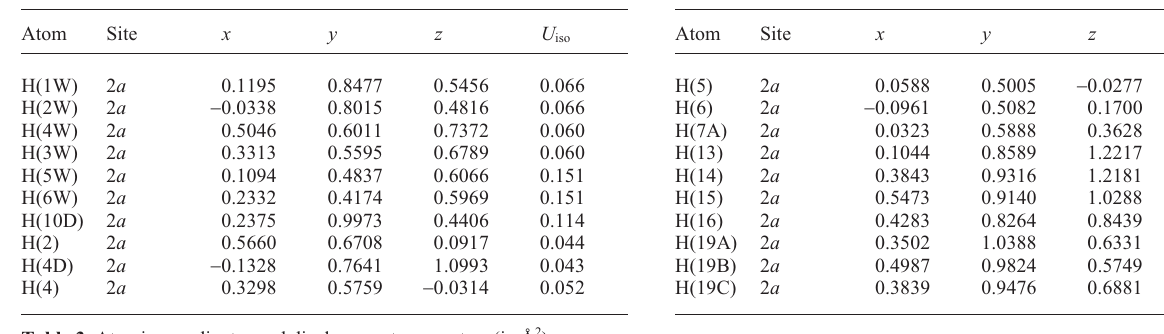
Table 2. Atomic coordinates and displacement parameters (in Å 2 )